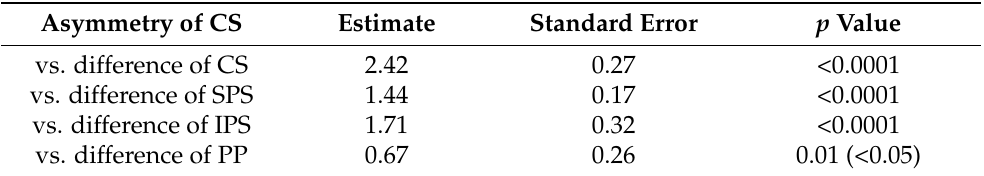
Table 3. Asymmetry of opacification in the cavernous sinus versus difference of CS, SPS, IPS, and PP by grading in 355 participants (cohort